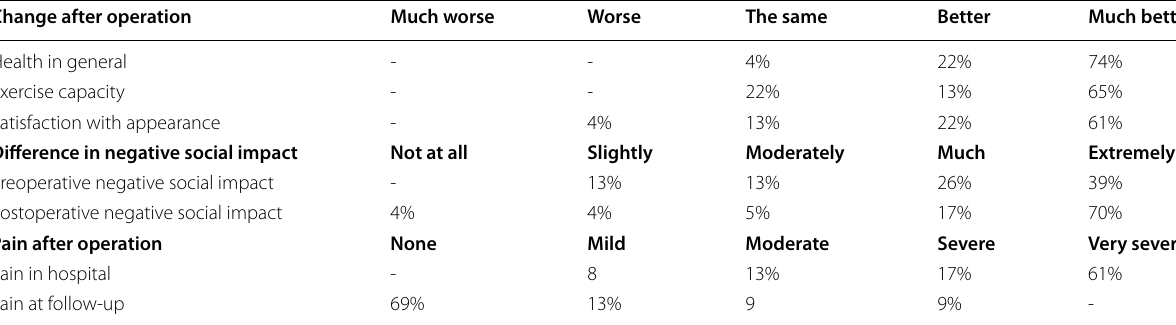
Table 4 Impact of operation on various aspects of quality of life Change after